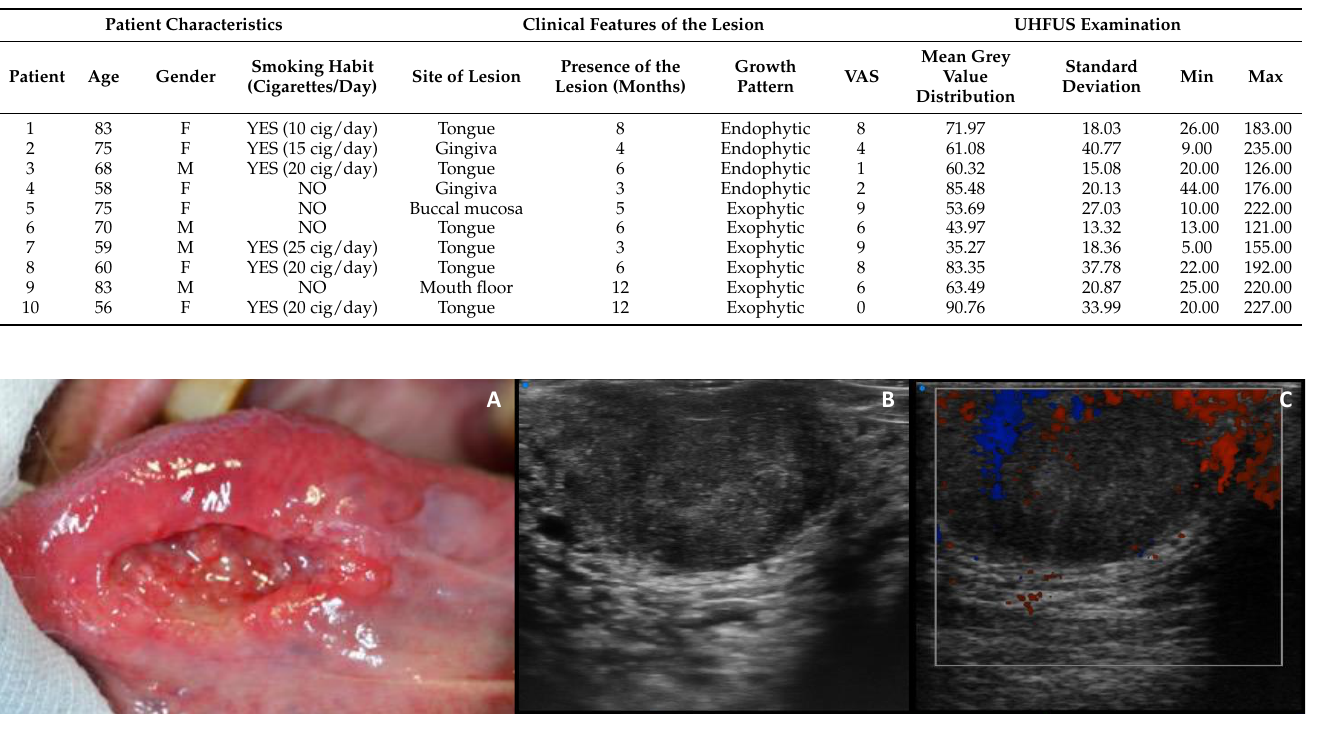
Figure 1. OSCC (oral squamous cell carcinoma) of the tongue margin in a 59-year-old male: ( A ) clinical aspect of the lesion, which appears to be ulcerated; ( B ) B-mode UHFUS (ultra-high frequency ultrasound) examination, showing the presence of an endophytic lesion, with unclear lateral margins and a mixed echogenic pattern; ( C ) color Doppler image, showing mild (score 1) perilesional vascularization.